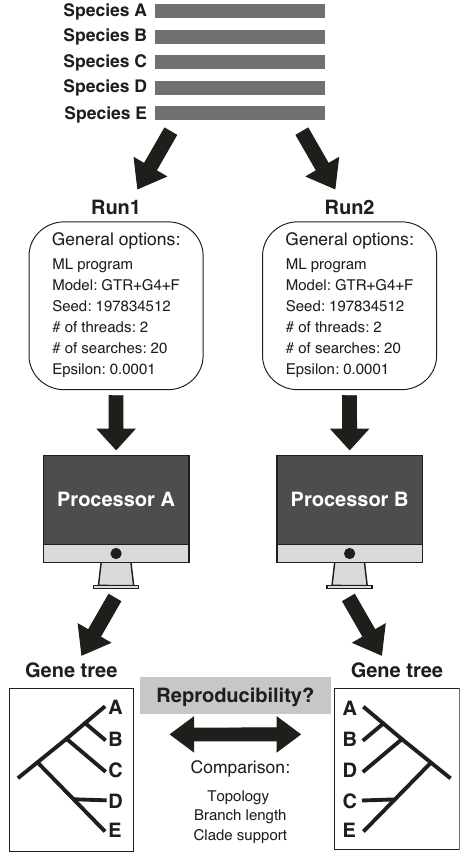
Fig. 1 Overview of assessing the reproducibility of